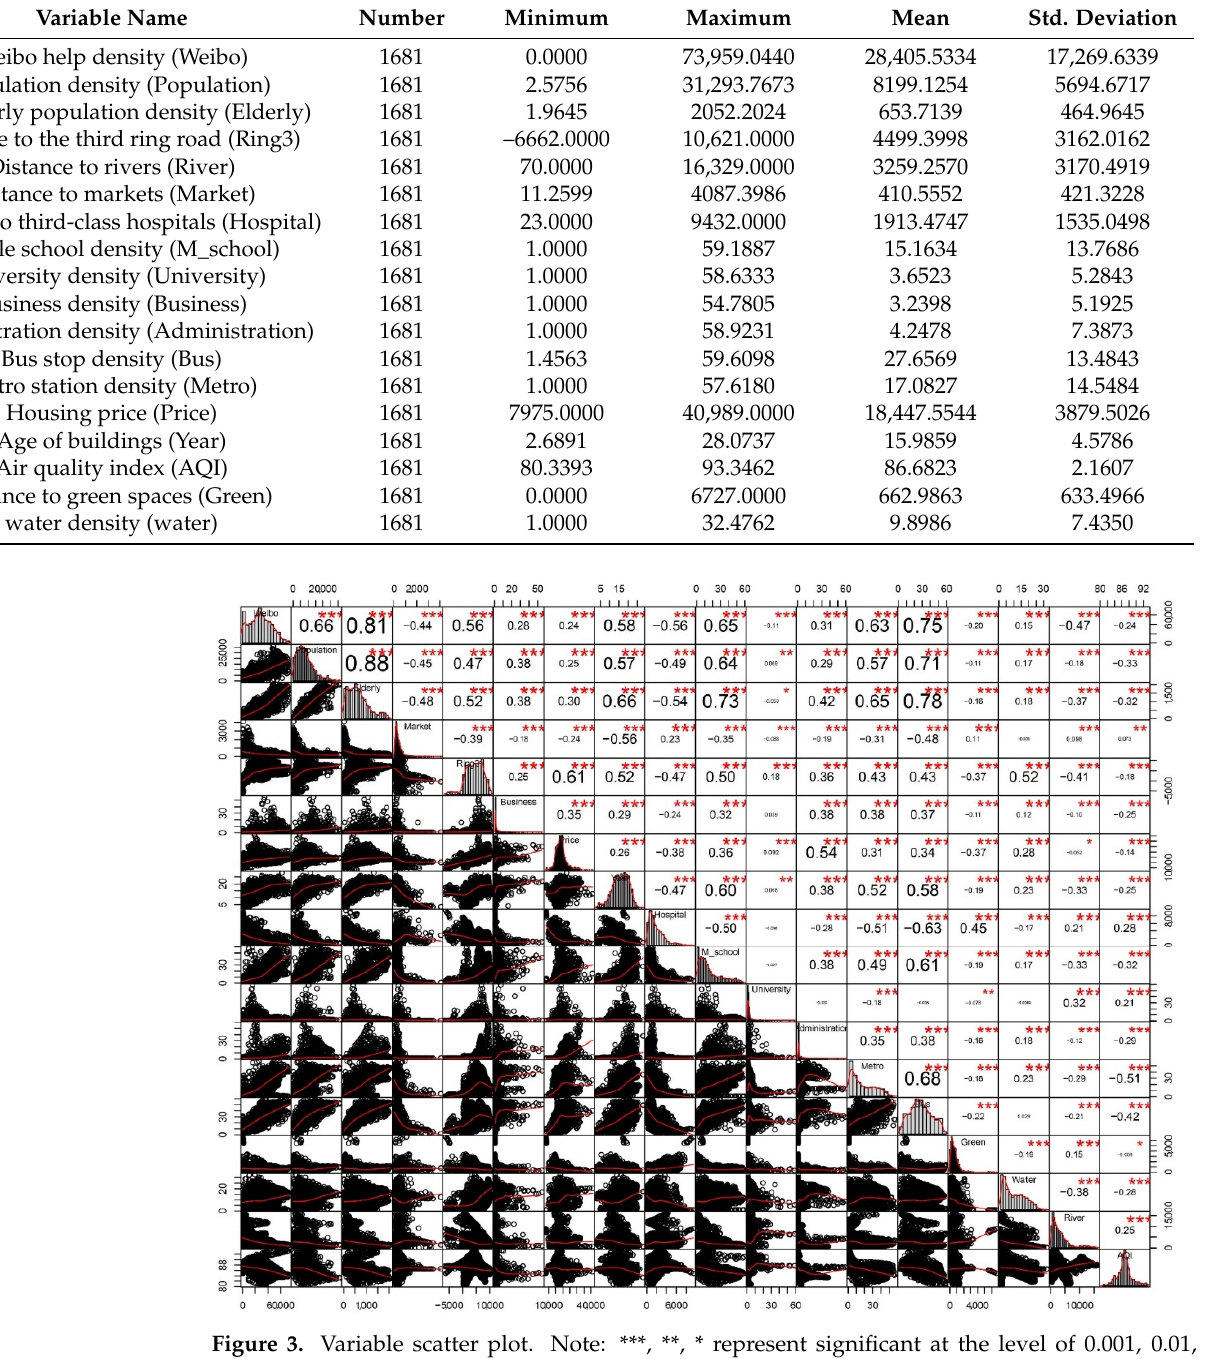
Table 5. Variable statistics.